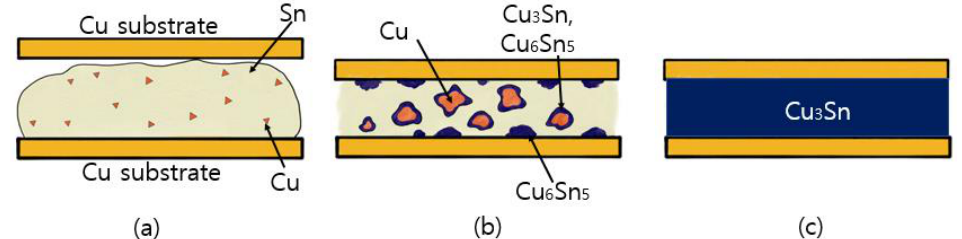
Figure 5. Effect of conventional and longer reflow process on IMC formation: ( a ) before reflow, ( b ) after a shorter time reflow, ( c ) after long time reflow.